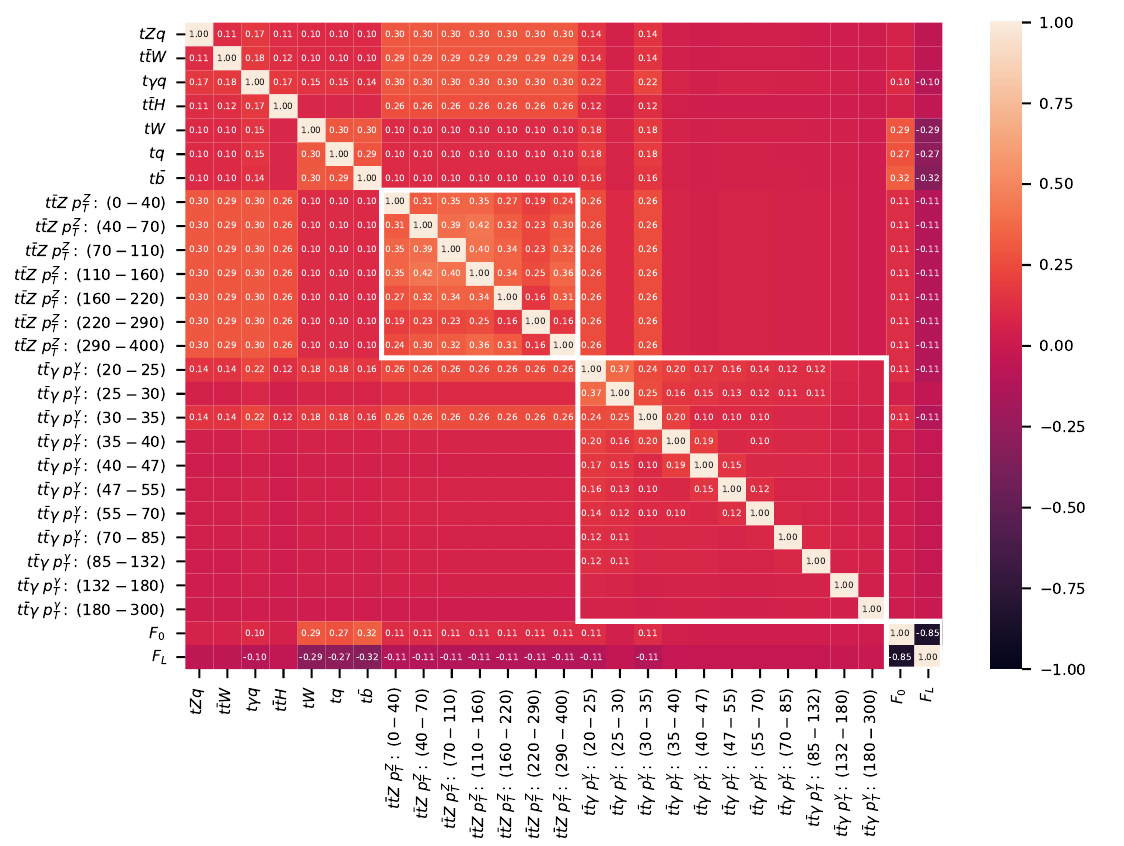
Figure 5 . Experimental correlation matrix used. The boxes in white correspond to the correlations published by the experiments for t ¯ tZ , t ¯ tγ and W boson helicity fractions [30, 33, 44]. The rest of the entries correspond to our ansatz, as described in section 8.3. Cells are filled if the correlation is higher than 10% in absolute